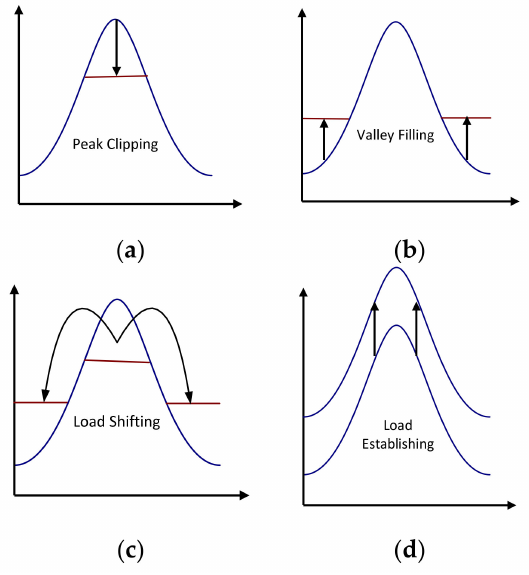
Figure 1. ( a ) Peak Clipping; ( b ) Valley Filling; ( c ) Load Shifting; ( d ) Load